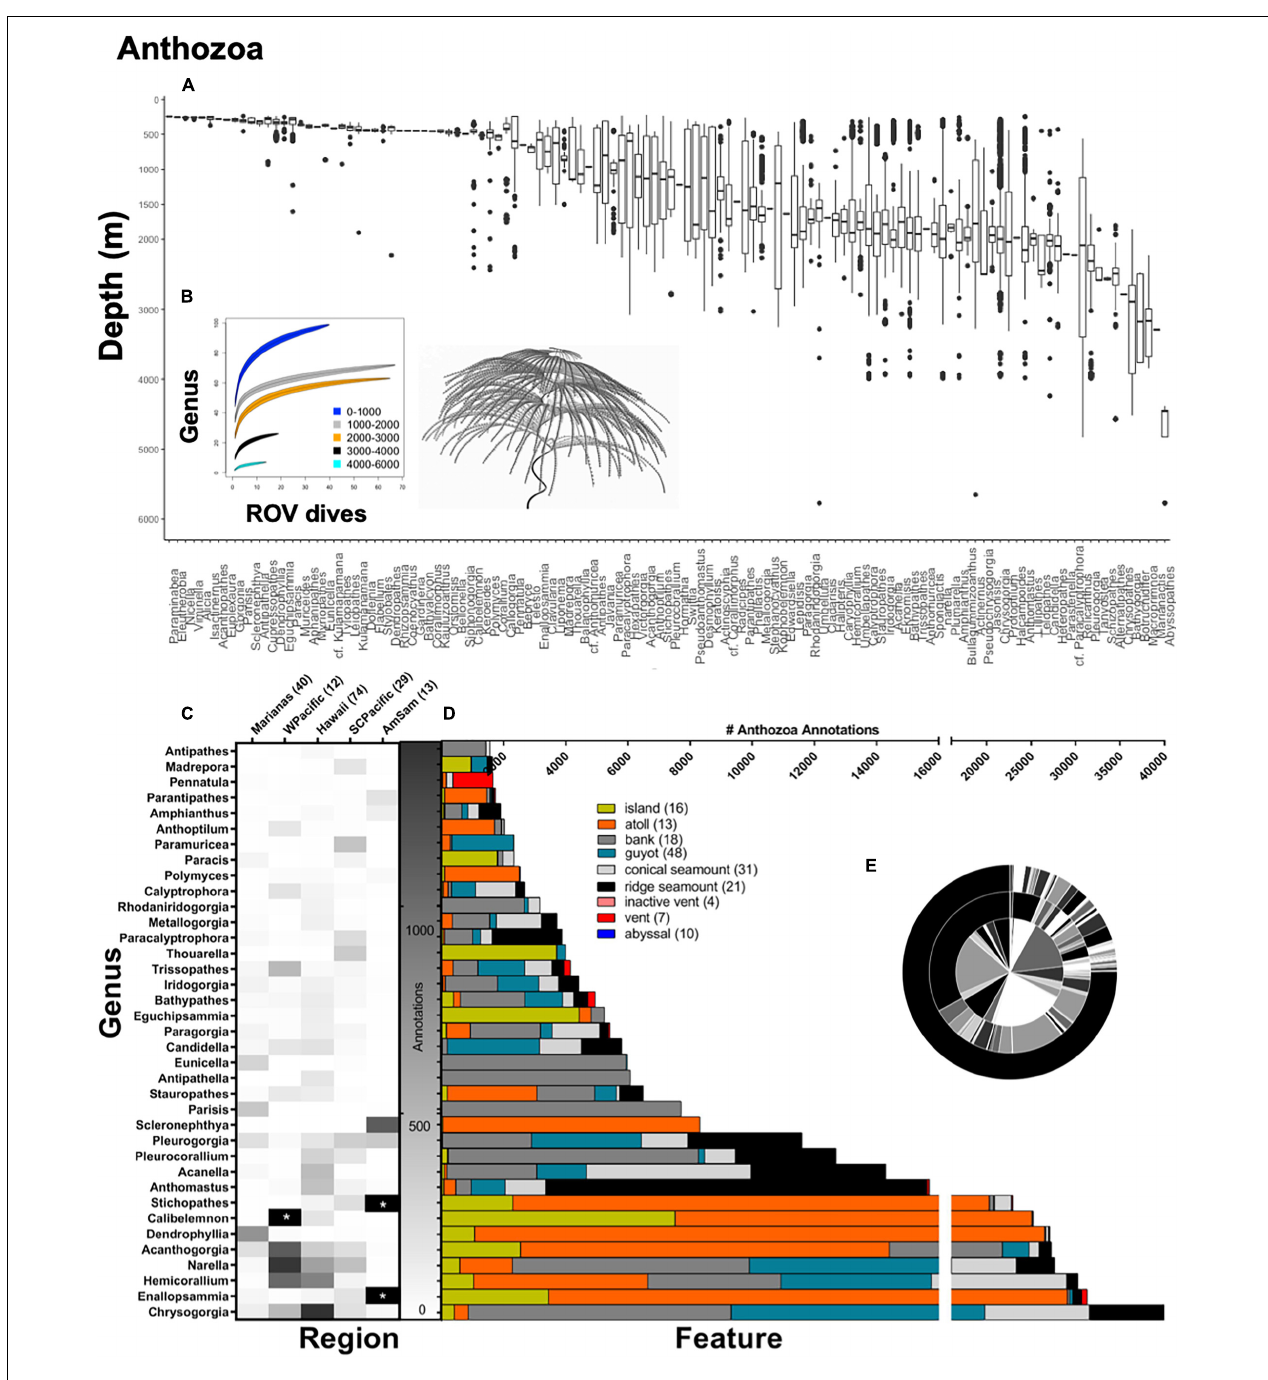
FIGURE 4 | Top panel: (A) Anthozoa annotations at the genus-level demarcated by depth (m). A total of 221,264 anthozoan annotations were used to make box-and-whisker plots, organized from shallow to deep along the x -axis. A total of 122 anthozoan genera were observed over CAPSTONE. Rarefaction curves (B) are shown for all of Anthozoa (122 genera), color coded by depth 0–1,000 m (blue) 1,000–2,000 m (gray), 2,000–3,000 m (orange), 3,000–4,000 m (black), and 4,000–6,000 m (cyan). Lines are drawn with a 95% confidence envelope. Bottom panel: Anthozoa annotations representing at the genus-level demarcated by (C) geographic region and (D) geologic feature; the number of dives for both are in associated parentheses. A total of 37 anthozoan taxa are shown, representing every genus where 1,500 observations or more were made during CAPSTONE. Starred boxes on heatmap represent abundances outside the range represented, specifically, 33,080.25 Enallopsammia spp. corals and 24,342.32 Stichopathes spp. were observed (corrected for effort) in American Samoa. Axis breaks by feature do not omit any data; breaks instead allocate annotation effort on different scales. (E) Nested pie chart shows overall taxonomic diversity at the family level (inner circle), genus level (middle circle), and species level (outer circle), for all anthozoans annotated. Unidentified annotations are represented by the largest black bar originating at 12:00, progressing